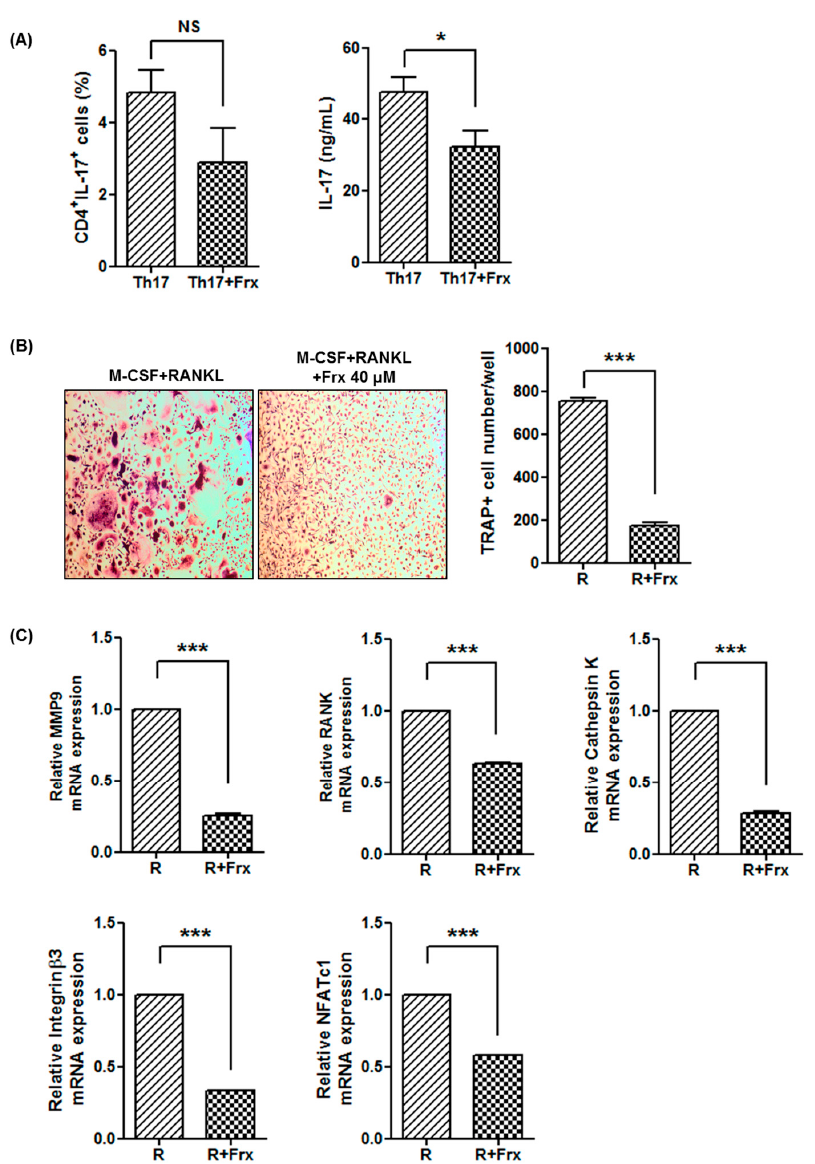
Figure 5. Fraxinellone regulates Th17 differentiation and osteoclastogenesis in human monocytes. ( A ) CD4 + T cells isolated from human peripheral blood mononuclear cells were cultured under Th17 differentiation conditions. After treatment with or without fraxinellone, the proportion of CD4 + IL17 + T cells and IL-17 production were determined using flow cytometry and enzyme-linked immunosorbent assays, respectively. ( B ) Human peripheral blood mononuclear cells were cultured with M-CSF and RANKL to induce osteoclastogenesis. The number of TRAP-positive multinucleated cells was counted in the culture dishes with or without fraxinellone (40 μ M) (original magnification ×100). ( C ) The expression levels of osteoclastogenesis-related markers, MMP9 , RANK , Cathepsin K , integrin β 3 , and NFATc1 were determined using RT-PCR in the absence or presence of fraxinellone (40 μ M). Data represent the mean of three independent experiments ± SEM. Frx, fraxinellone; M-CSF, macrophage-colony stimulating factor; RANKL, receptor activator of nuclear factor- κ B ligand; TRAP, tartrate-resistant acid phosphatase; MMP9, matrix metalloproteinase 9; RANK, receptor activator of nuclear factor- κ B; NFATc1, nuclear factor of activated T-cells 1; R, culture with M-CSF and RANKL; R + Frx, culture with M-CSF, RANKL, and fraxinellone; NS, not significant; * p < 0.05; *** p < 0.001.